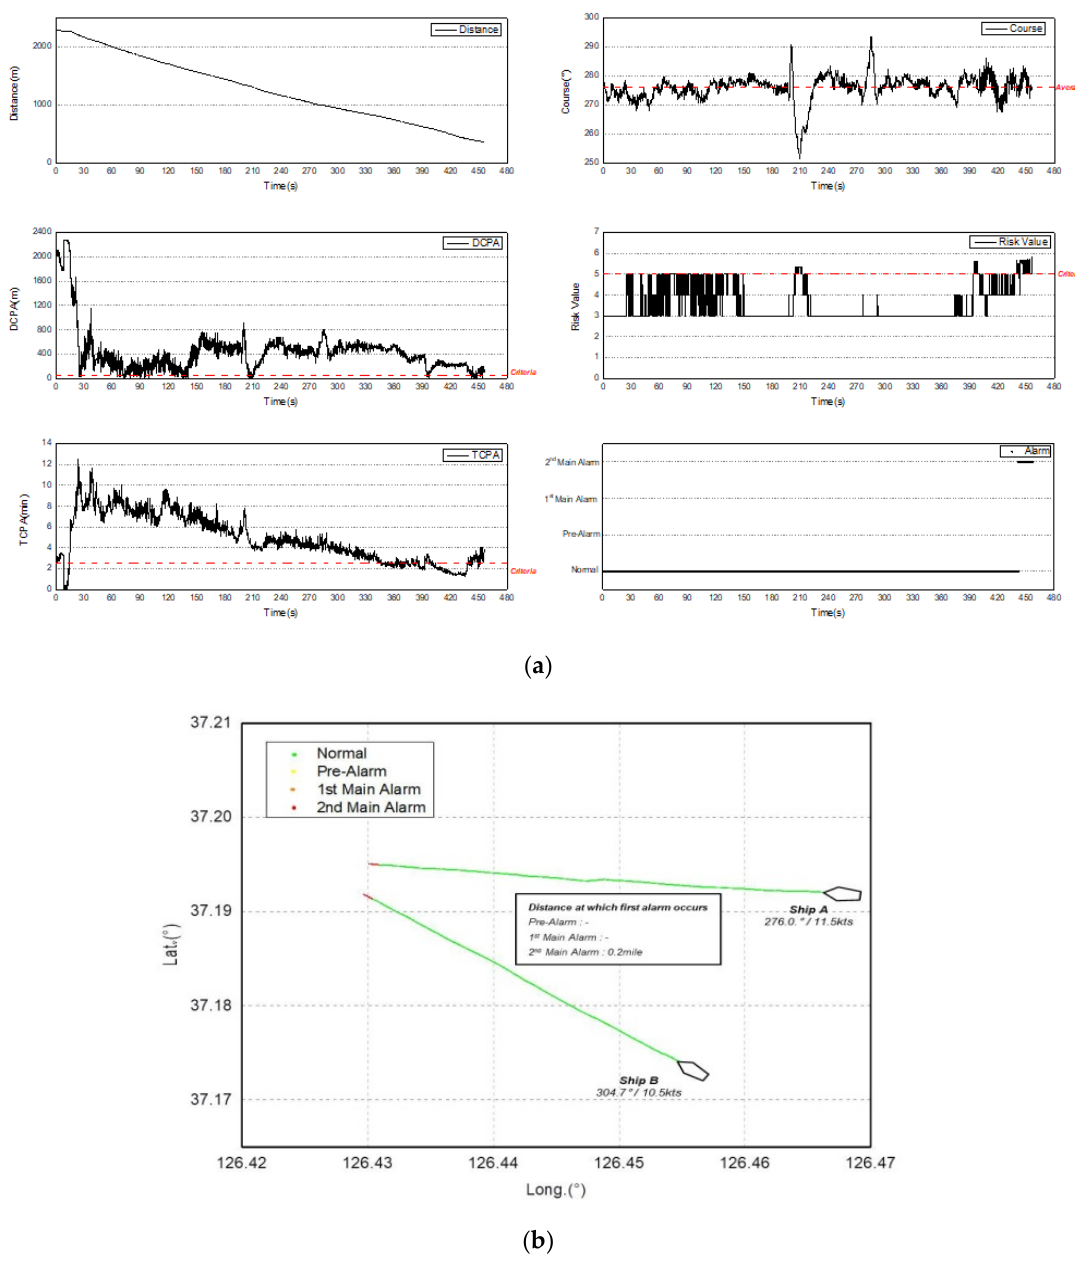
Figure 14. ( a ) Experimental results; ( b ) track and alarm analysis for.